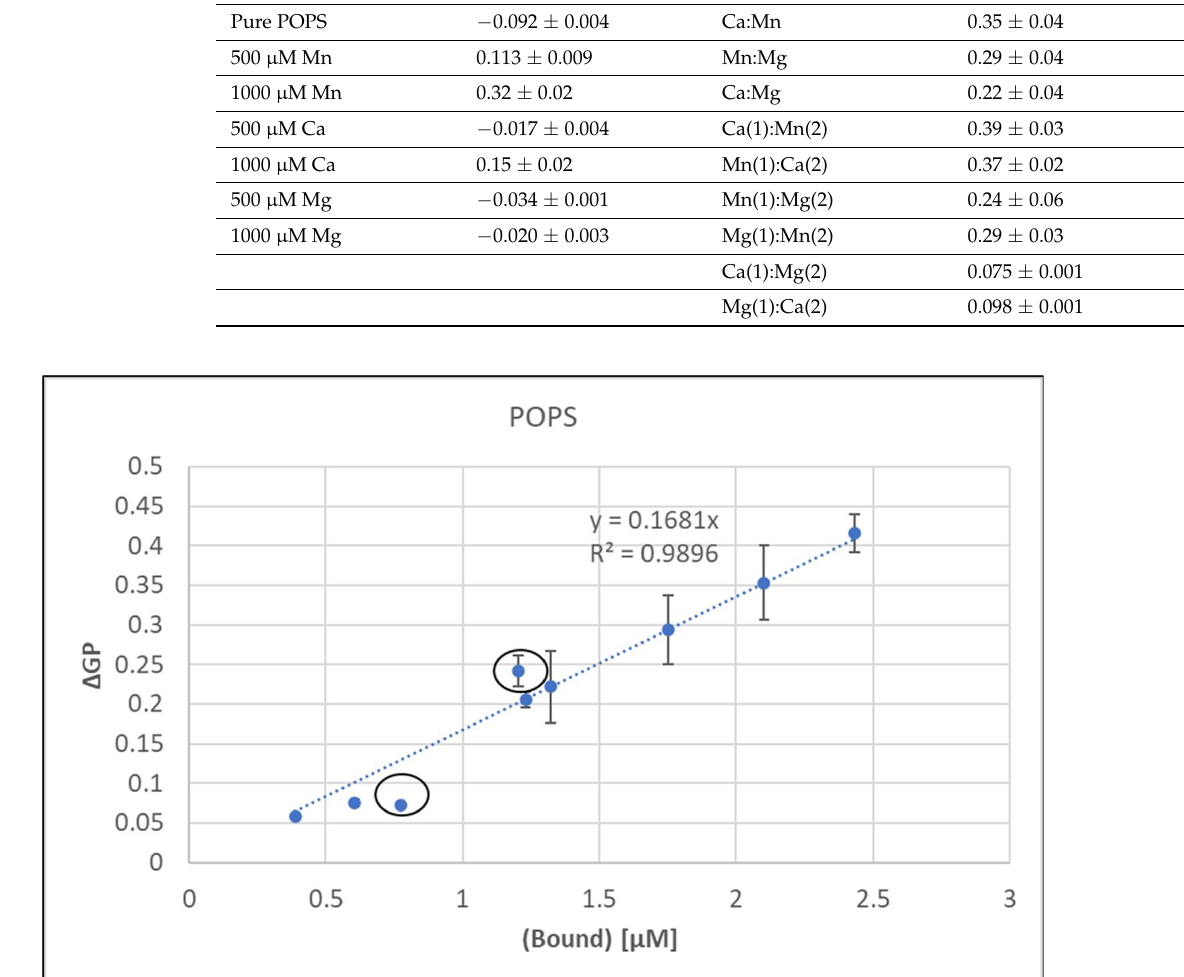
Figure 3. GP versus bound metal concentrations of Mn, Ca, Mg and binary mixtures. The high- lighted points will be discussed in the text. points will be discussed in the text.